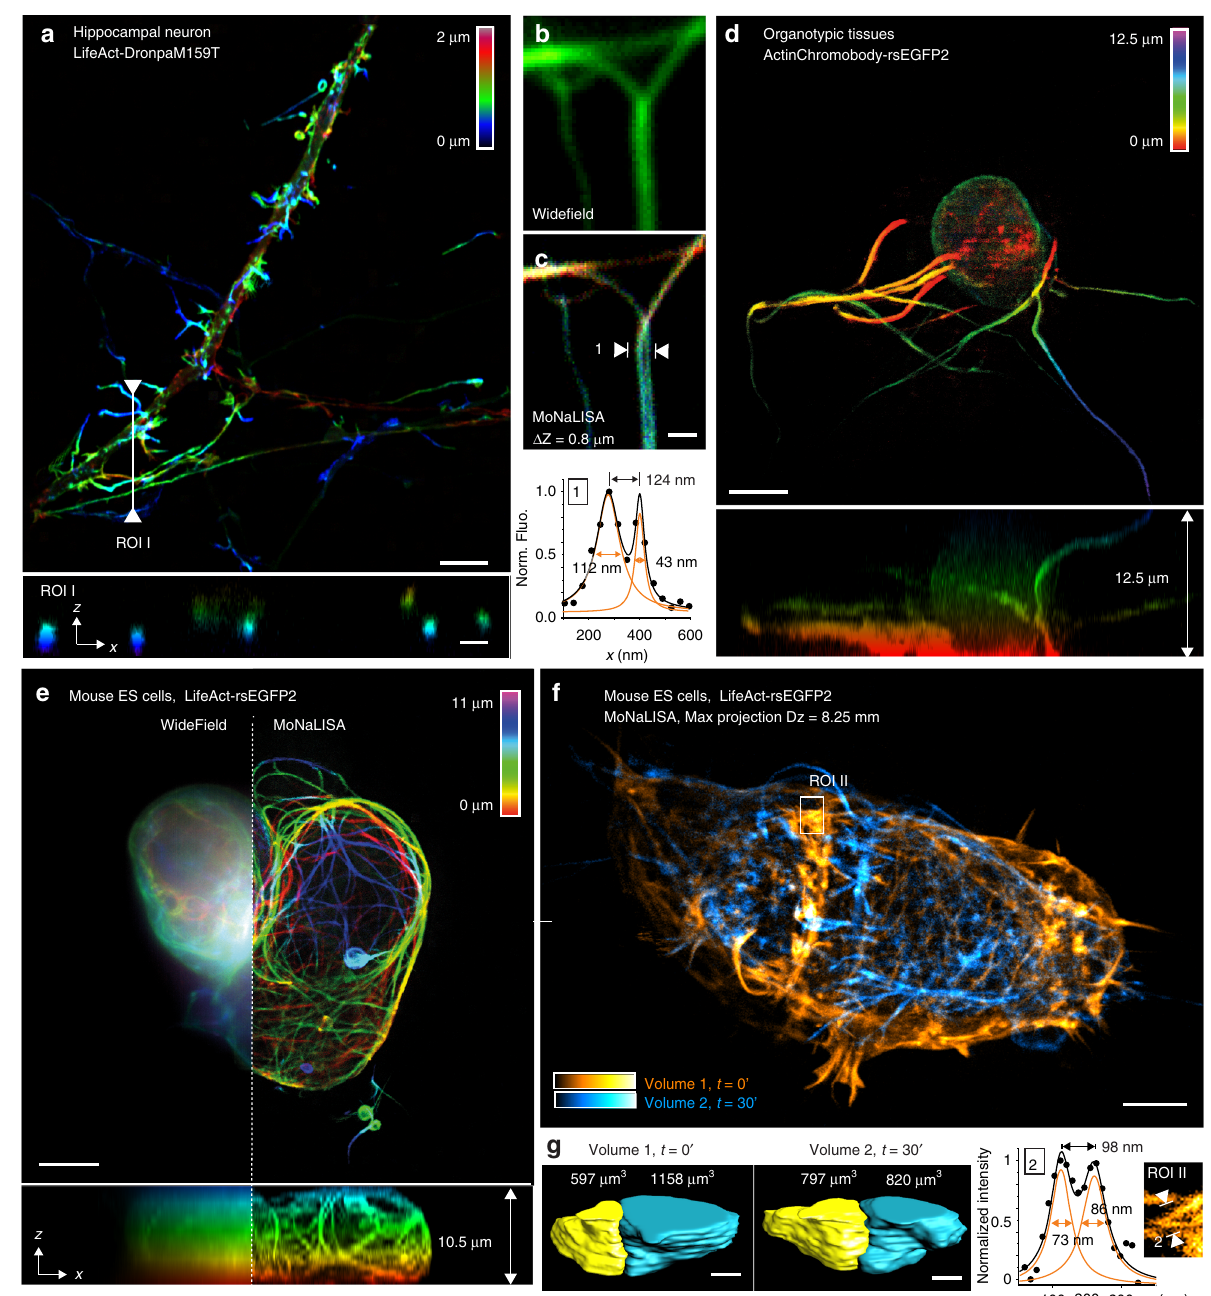
Fig. 3 Optical sectioning and 3D recordings in living cells and organotypic tissues. a 3D stacks of 15 DIV neurons expressing LifeAct-DronpaM159T with MoNaLISA. The fi ne optical sectioning reveals the color-coded depth information in the x – y and x – z maximum projections. Scale bar, 5 μ m. b and c Comparison between wide- fi eld and MoNaLISA imaging of a neuron expressing LifeAct-rsEGFP2. The line pro fi les measured in the MoNaLISA image were averaged over four lines and fi tted with a Gaussian. d Young brain cell recorded in an organotypic hippocampal rodent brain tissue and represented in an x – y and x – z maximum projection. Scale bars, 5 μ m. e Colony of mouse ES cells spanning 30 × 30 × 11 µ m 3 imaged in the volumetric imaging mode. The scan steps are 35 nm in x – y and 500 nm in z . The images report fi ne structures across the entire z depth (right), hidden in the wide- fi eld comparison (left). f Two volumes of mouse ES stem cells composed of 33 frames for a total axial depth of 8.25 μ m has been recorded. The frame recording time was 2.9 s. We waited 30 min between volumes to observe the rearrangements of the actin network upon transfer to serum-free conditions. Scale bar, 5 μ m. g The volumetric rendering of the two cells over time shows a clear shift in volume ratio in physiological (volume 1) versus the starving (volume 2) condition. ROI I is the magni fi ed region of a single section and highlights fi ne actin bundles of sub-100 nm